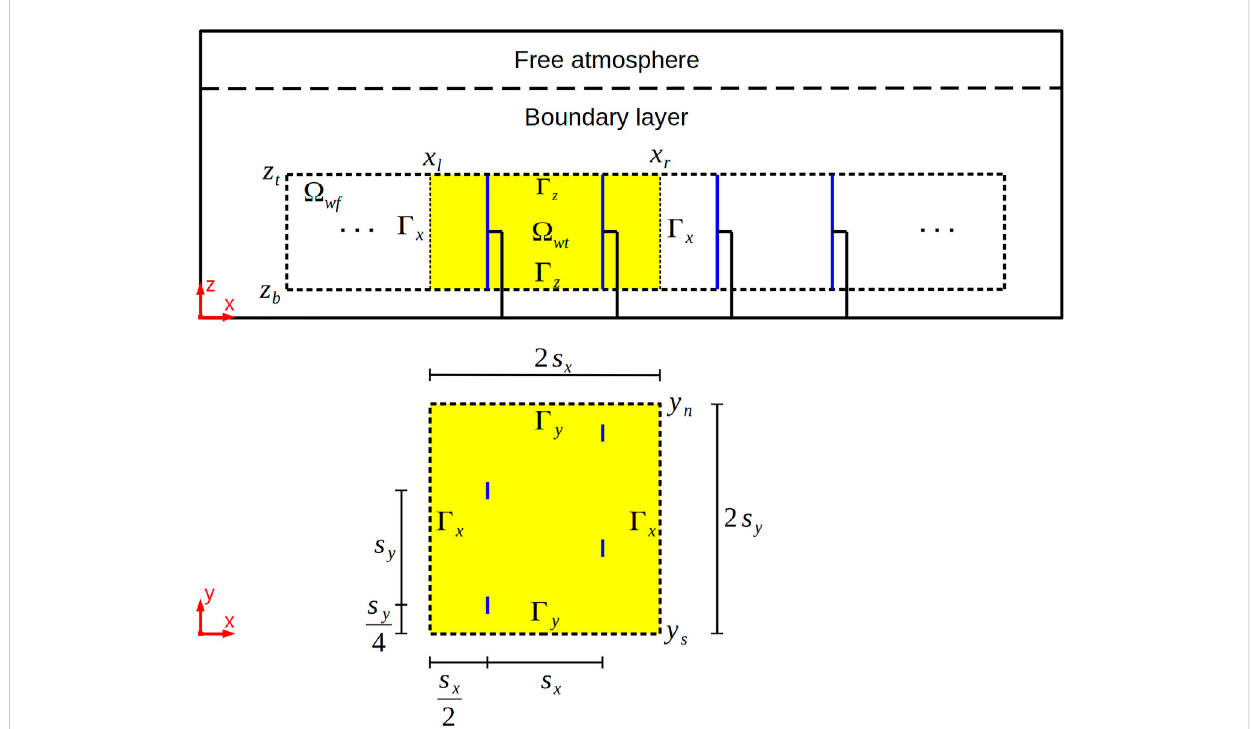
FIGURE 6 Sketch of the wind turbine control volumes Ω wt and the wind farm control volume Ω wf . In x -direction the control volumes are bounded by the boundaries Γ x at x = x l (left) and x = x r (right). In the vertical direction, the control volumes are bounded by Γ z at z = z b (bottom) and z = z t (top). In y - direction the control volumes are bounded by Γ y at y = y s (south) and y = y n (north).